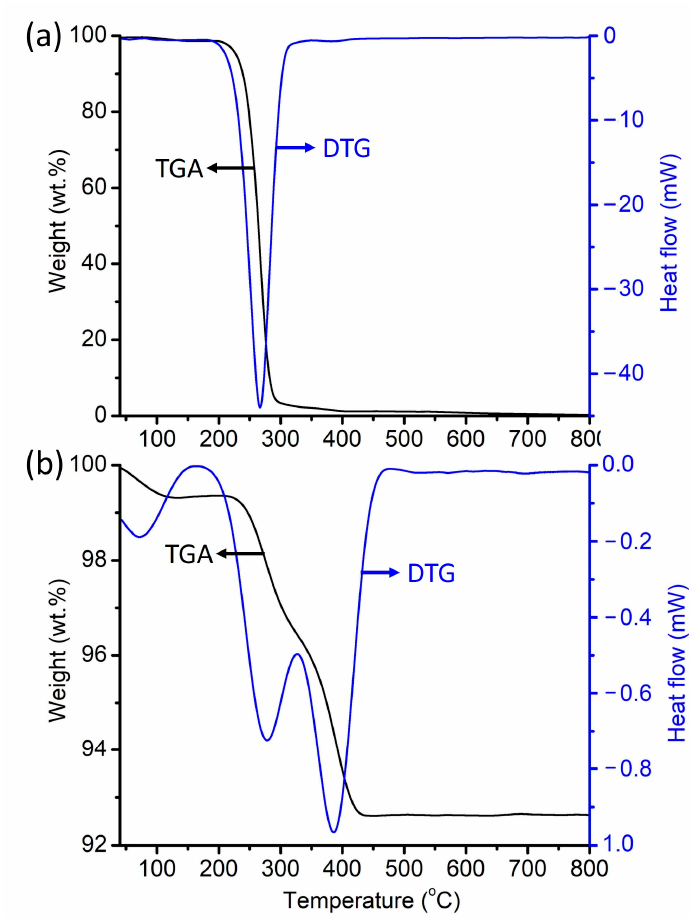
Figure 6. TGA/DTG curves of ( a ) free [PPy]Br ionic salt and ( b ) as–synthesized SAPO-11 (E-3).